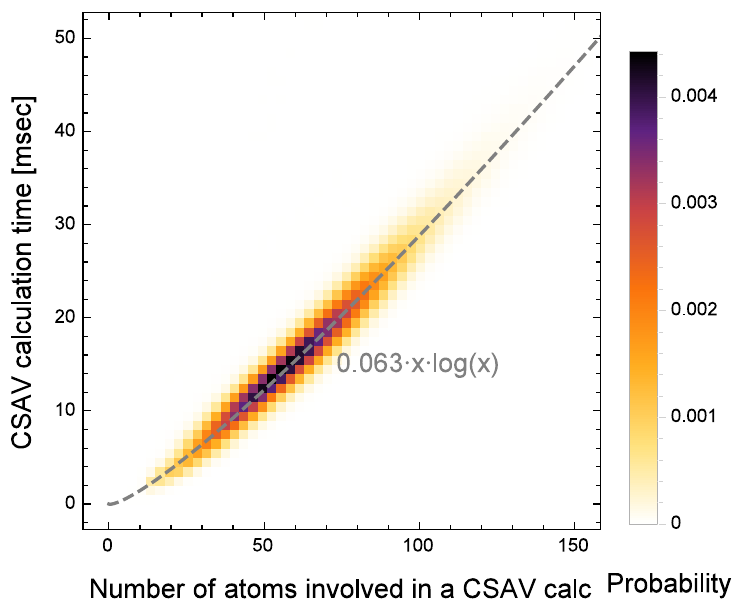
Fig 7. The probability of calculating a CSAV in y time when x number of atoms are involved in the calculation. The dashed line is the least-square fit of the log-linear function to the